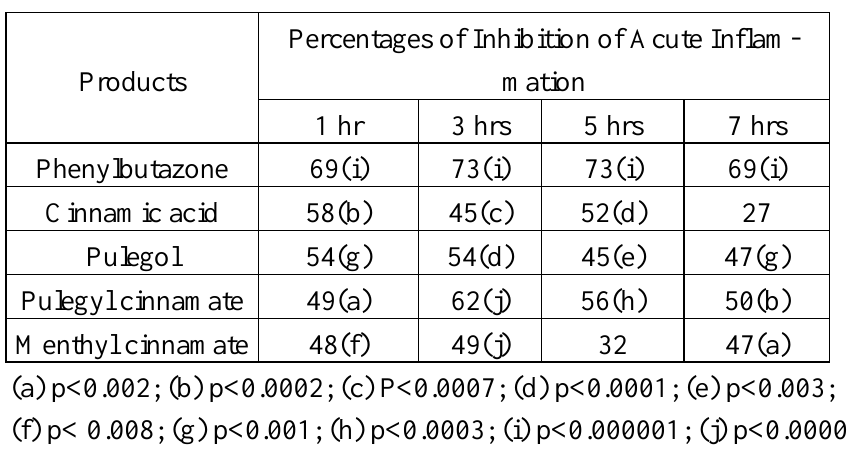
Table 1. Carrageenan